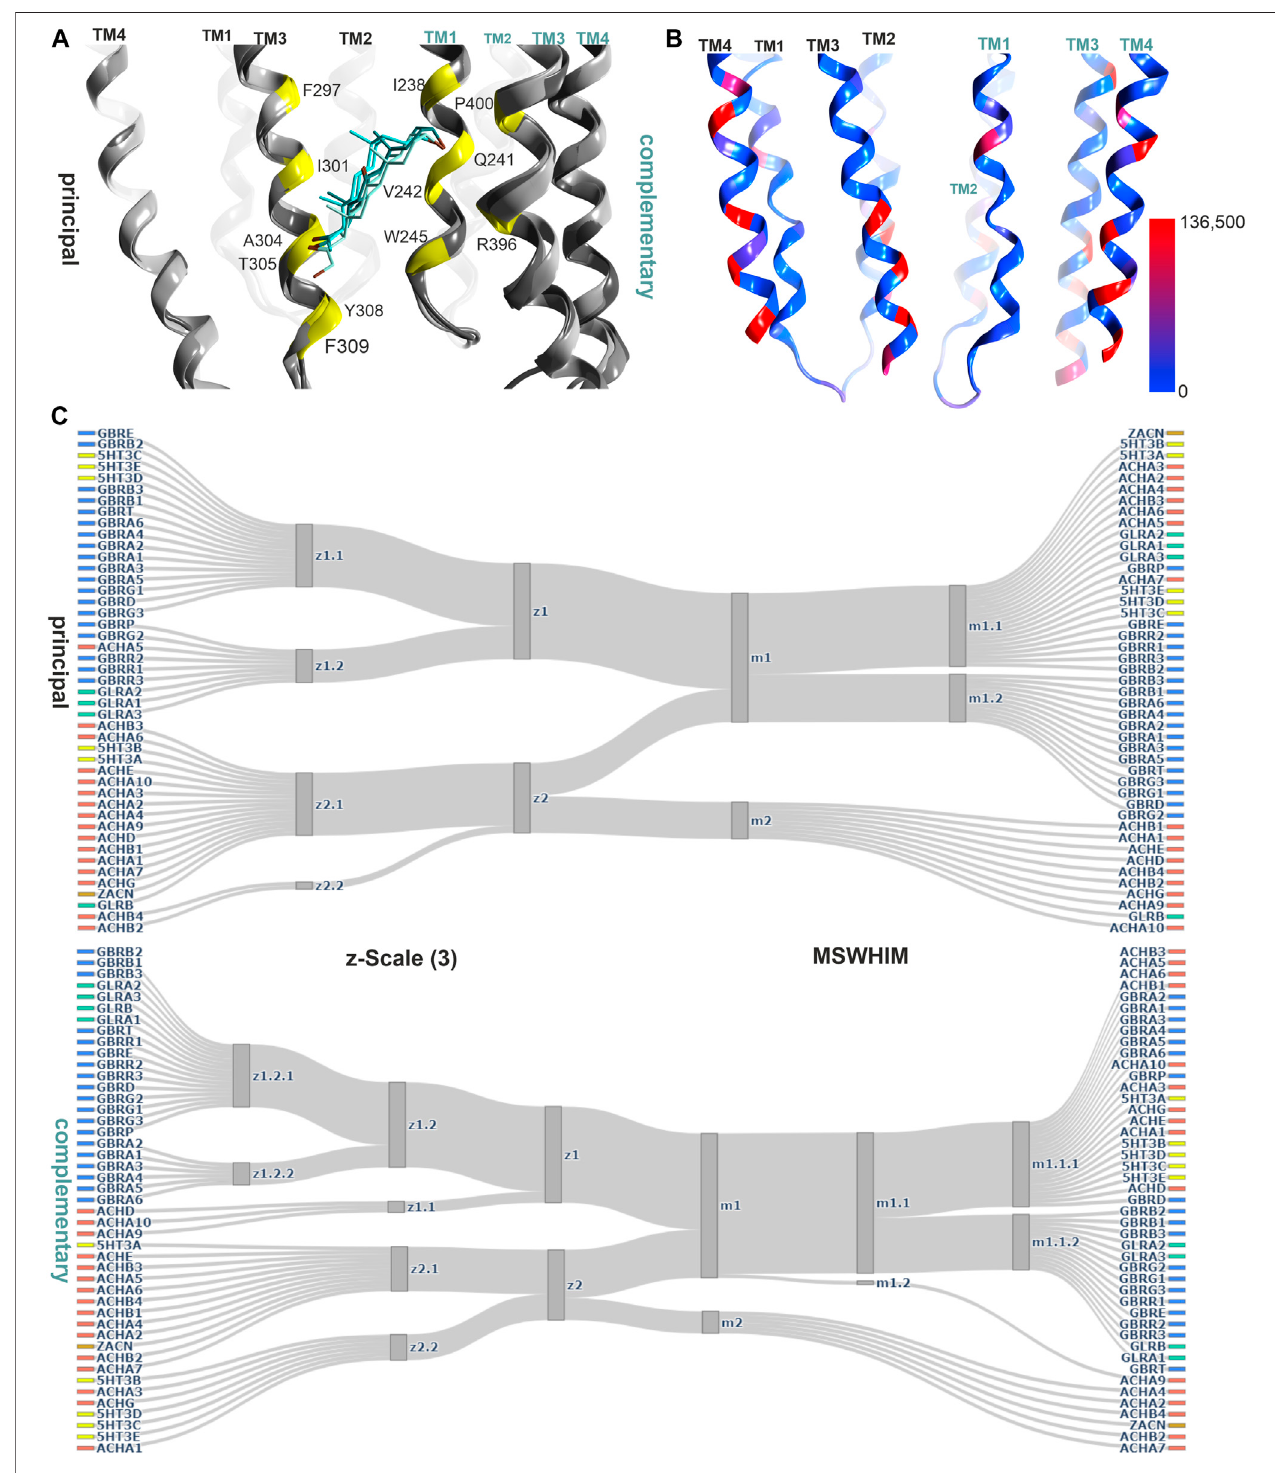
FIGURE 6 | Representative structures of the lower TMD interface steroid pocket, and descriptor analysis: (A) Ribbon of the structures with modulatory steroids at the lower TMD interface: 6CDU — alphaxalone (dark green), 5O8F — pregnanolone (cyan), 5OSB — THDOC (light green). The yellow places on the ribbon indicate the binding site forming positions which were used for the pocket analysis computations. (B) Amount of variants across all genes of interest in the region of this binding site mapped onto 7EKT. Ribbon heatmap represents the sum of minor allele counts per 100,000 at each aligned position. See Supplementary Figures S18,S19 for detailed heatmaps. (C) Comparison diagrams derived from hierarchical clustering of z- Scale(3) and MSWHIM descriptors asestimates for similarities. Supplementary Figures S15,S16 depict the full dendrograms.